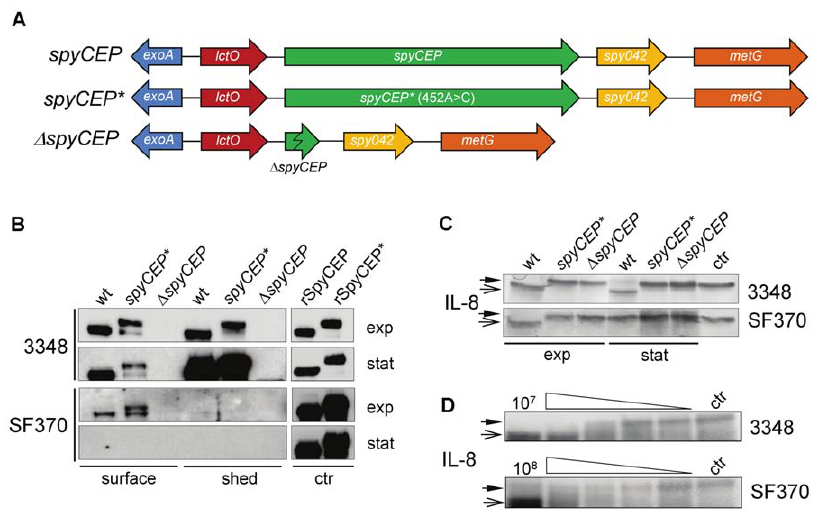
Figure 1. Localization and activity of SpyCEP. ( A ) Schematic representation of SF370 wild type and genetically manipulated spy0416/spyCEP loci. The same mutagenesis was conducted in the 3348 strain. The base substitution 452A . C is indicated (*). ( B ) Western blot analysis of cell wall extracts or supernatants from the 3348 and SF370 w.t. and mutant strains. SpyCEP was detected using rabbit polyclonal a -SpyCEP serum. 10 ng of rSpyCEP or rSpyCEP* were added as controls (ctr). ( C–D ) IL-8 cleavage assay with washed live bacteria. SDS-PAGE and silver staining were performed after digestion of IL-8 (10 m g/ml) in the presence of 10 m g/ml of chloramphenicol. Uncleaved and cleaved IL-8 are indicated by full and trace arrowhead respectively. Control lane (ctr) is IL-8 alone. ( C ) Strains were grown to exponential or stationary phase, resuspended in PBS at comparable bacterial densities ( , 10 9 CFU), and then incubated with IL-8. ( D ) Exponential phase bacteria 3348 w.t. (10 7 CFU) and SF370 w.t. (10 8 CFU) were serially diluted in PBS using 4 fold steps before incubation with IL-8.